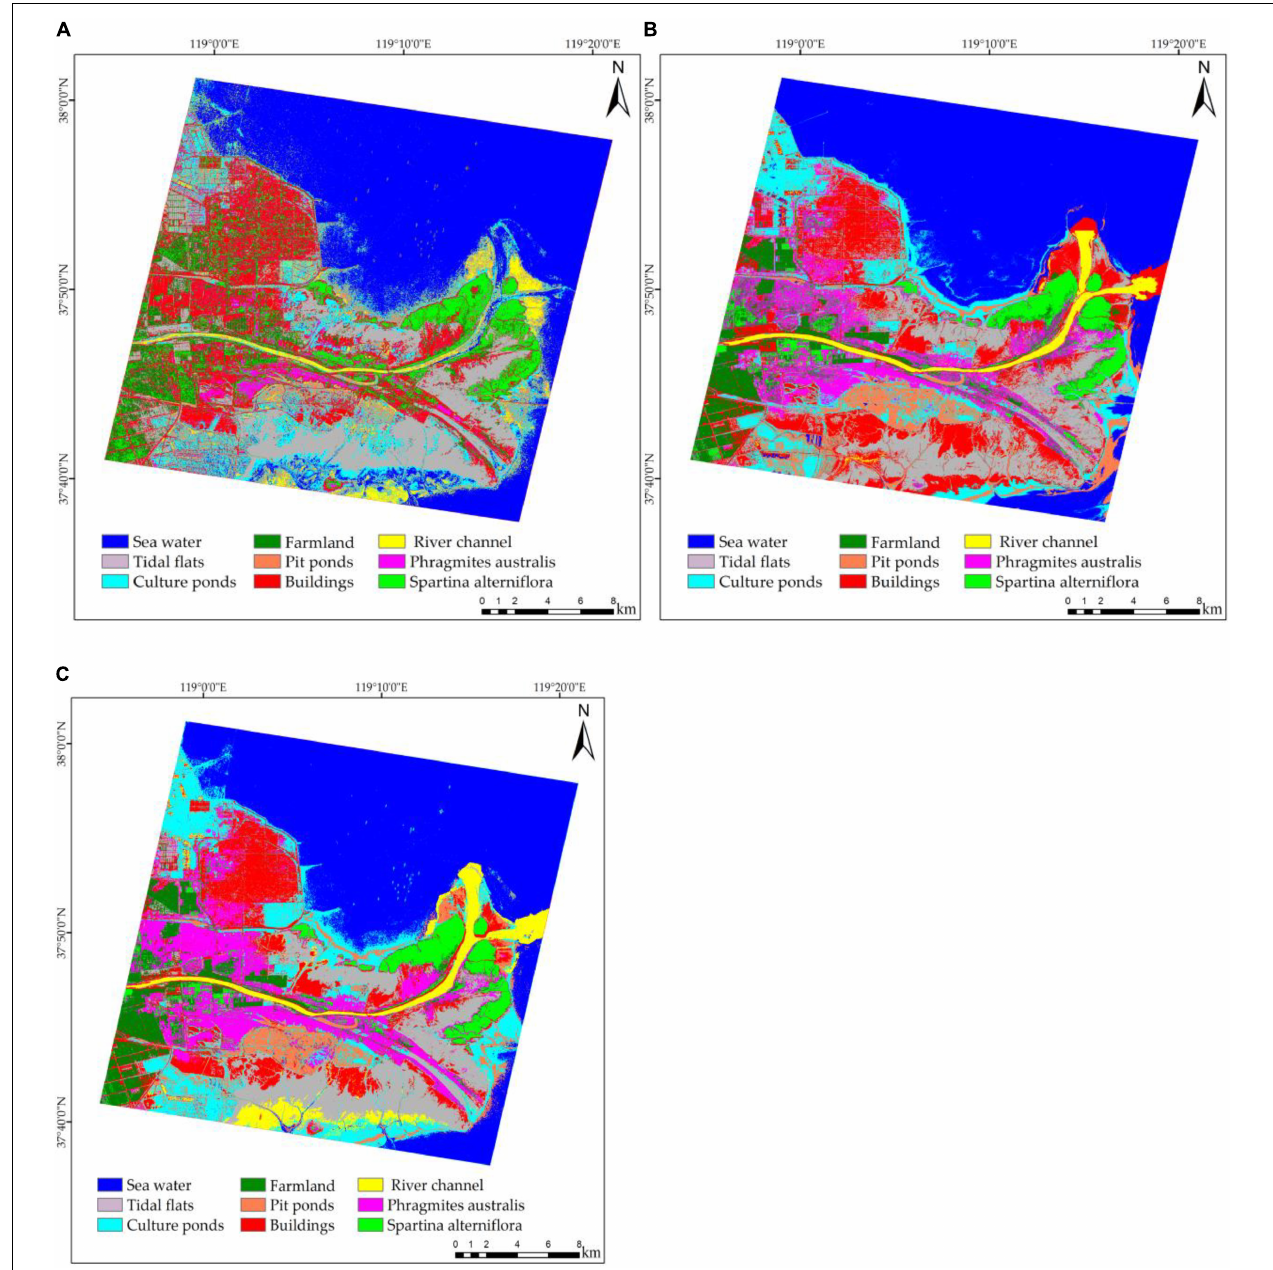
FIGURE 8 | RF classification results based on different features using November 2018 data: (A) The RF with polarimetric features; (B) The RF with spectral features; and (C) The RF with joint